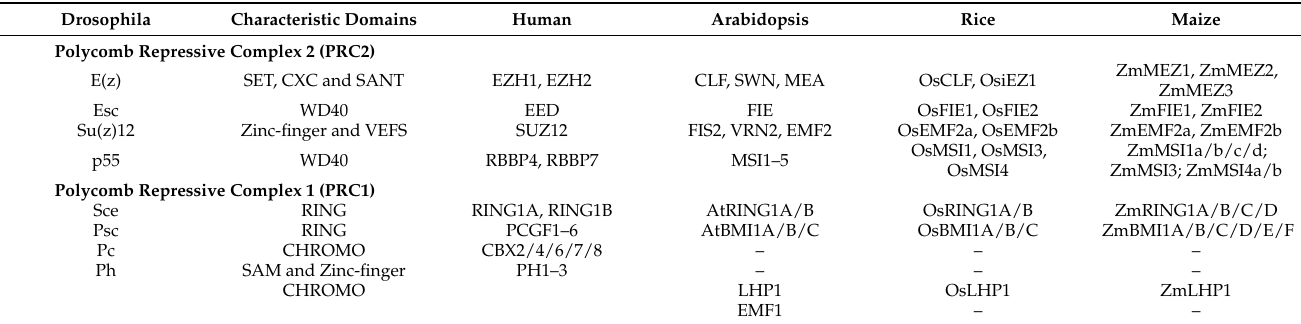
Table 1. PRC1 and PRC2 core complex components in animals and